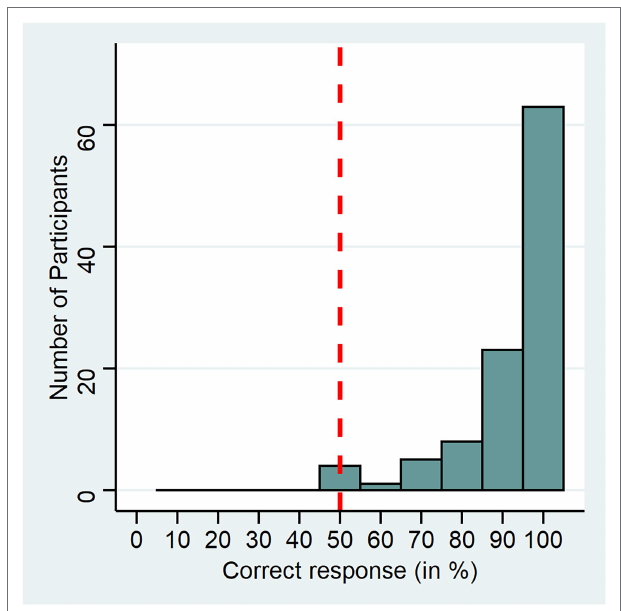
FIGURE 2 | Pitch discrimination task performance. The x-axis shows the percentage of correct responses from the 10 trial 2-IFC experiment, the y-axis shows the number of participants for each bin. The dashed line shows chance level (50%).